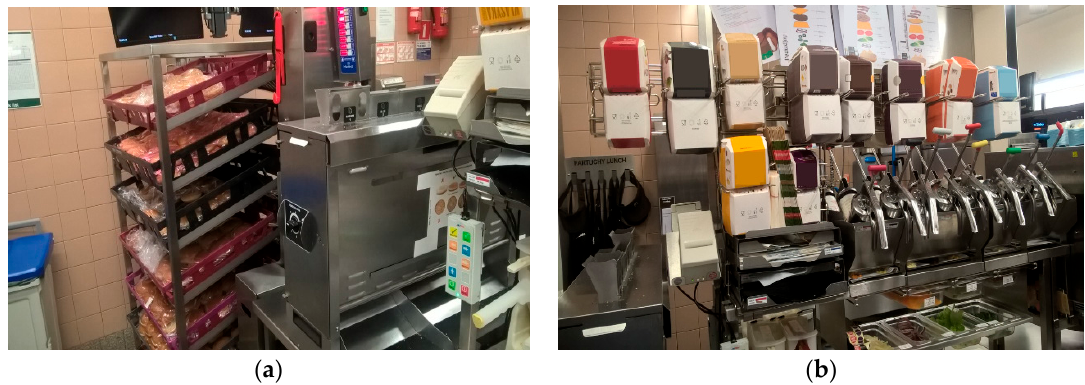
Figure 3. Areas in the restaurant: ( a ) an initiation work station with a roll rack; ( b ) packaging racks.